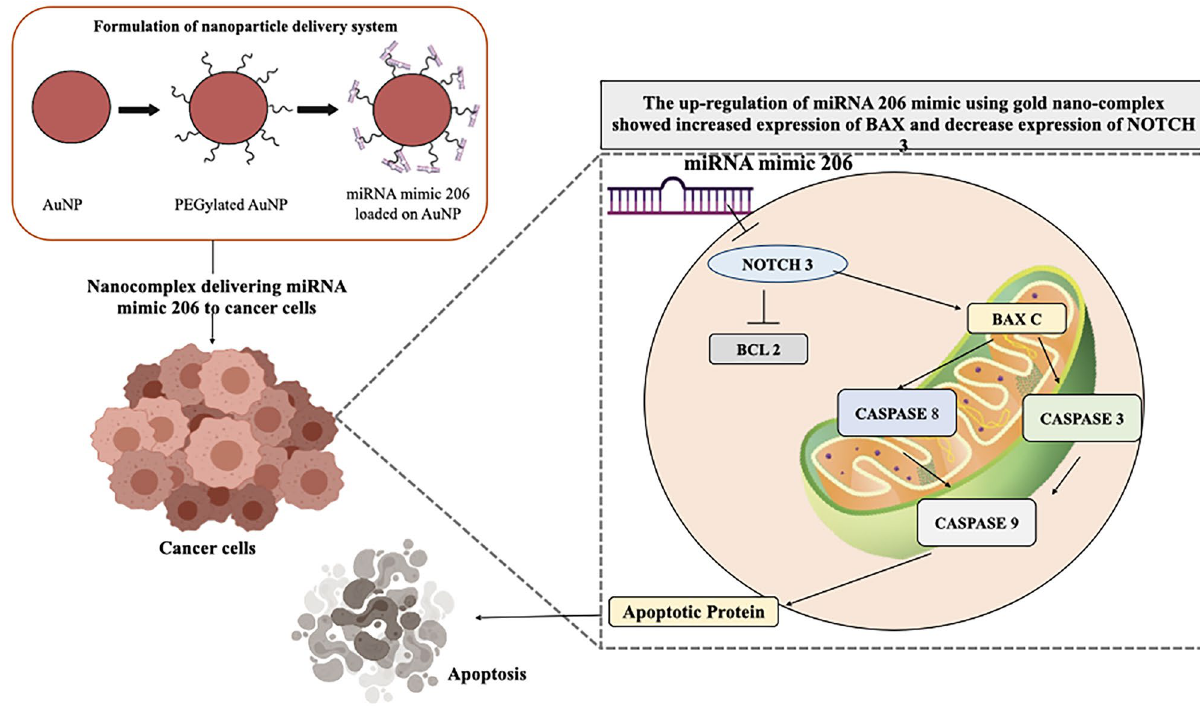
Figure 8. Schematic representation of the